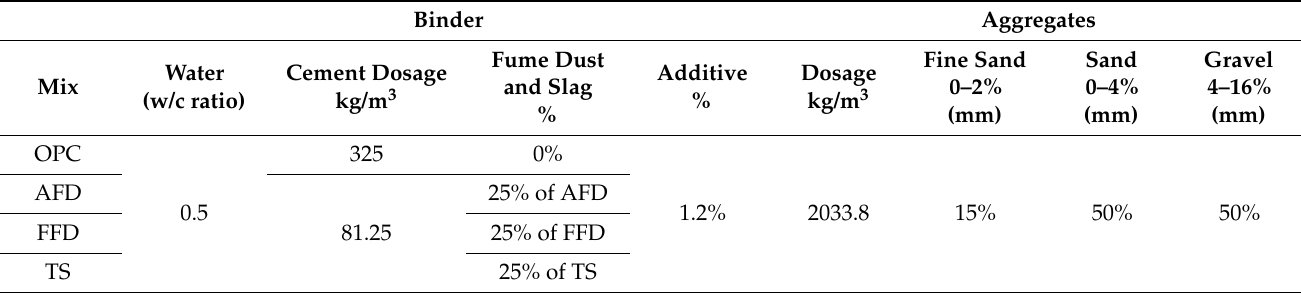
Table 3. Organisation of experimental kneading